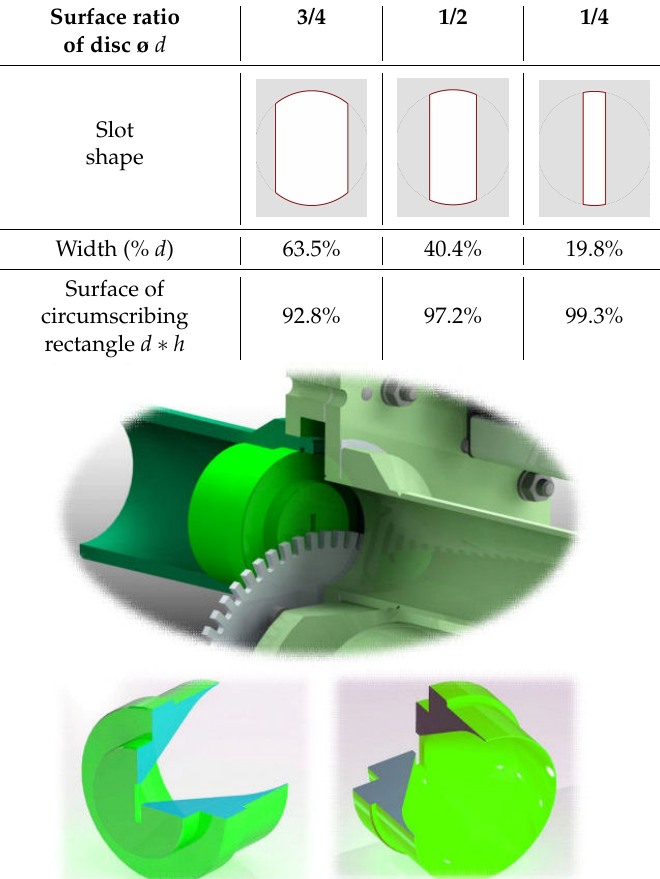
Figure 7. Novel nozzle profiles showing a slot-like outlet, for several round surface ratios ( top ), nozzle arrangement with wheel ( middle ), and nozzle cut views ( bottom